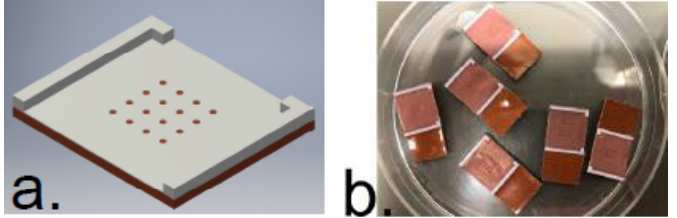
Figure 4: a. The design of the sample as it's attached to the composite. b. The prepared samples with different diameters and